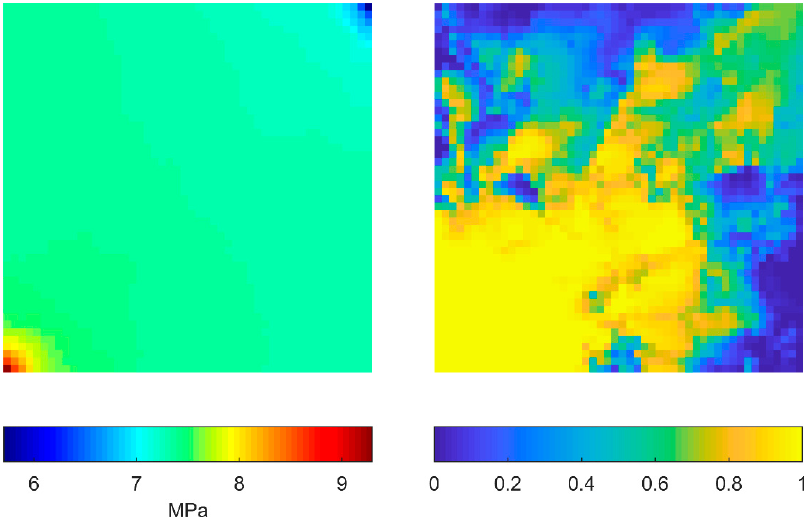
Figure 18. Case 3: reference solution for pressure distribution ( left ) and tracer concentration distribution after 2 PVI ( right ). Energies 2020 , 13 , x FOR PEER REVIEW